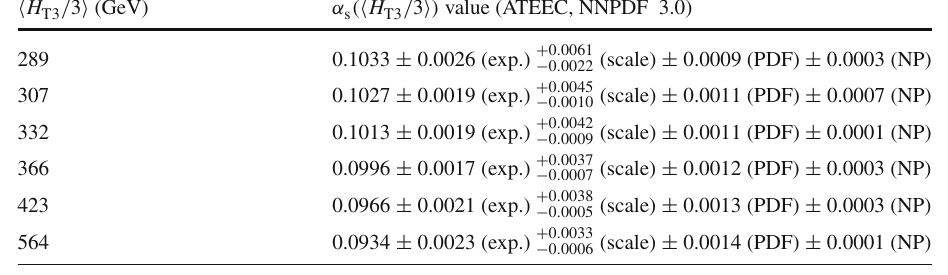
Table 13 Values of α s , obtained from ATEEC fits, evolved to the average value of transverse momentum for every pair of jets in each event, (cid:4) ( p T i + p T j (cid:5) / 2 for each bin in H